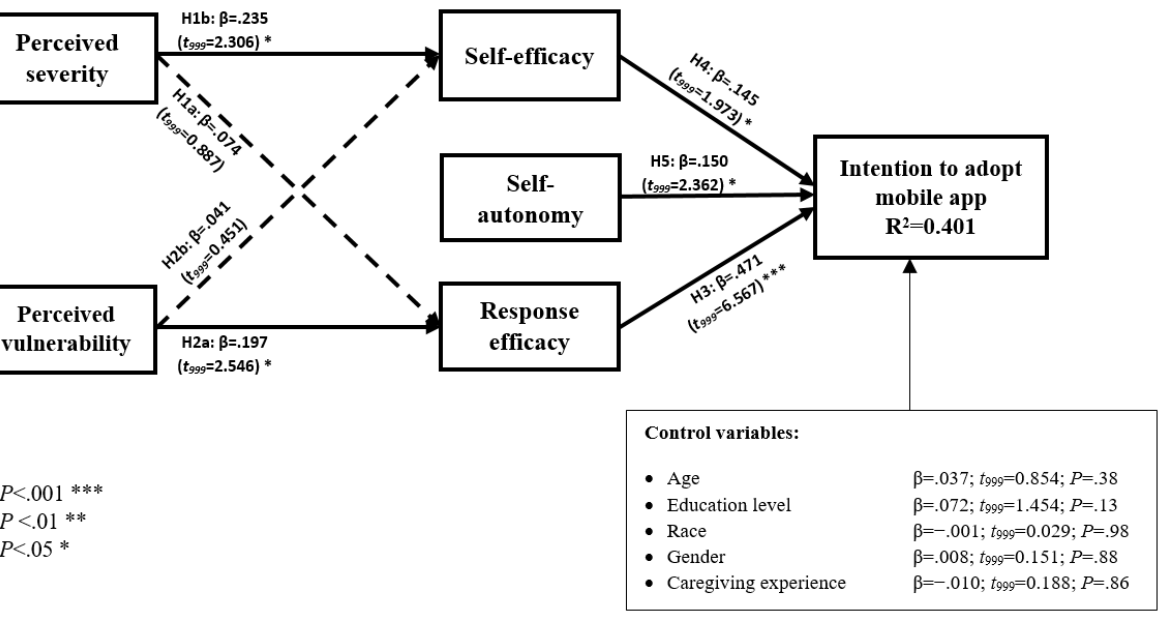
Figure 3. Partial least squares